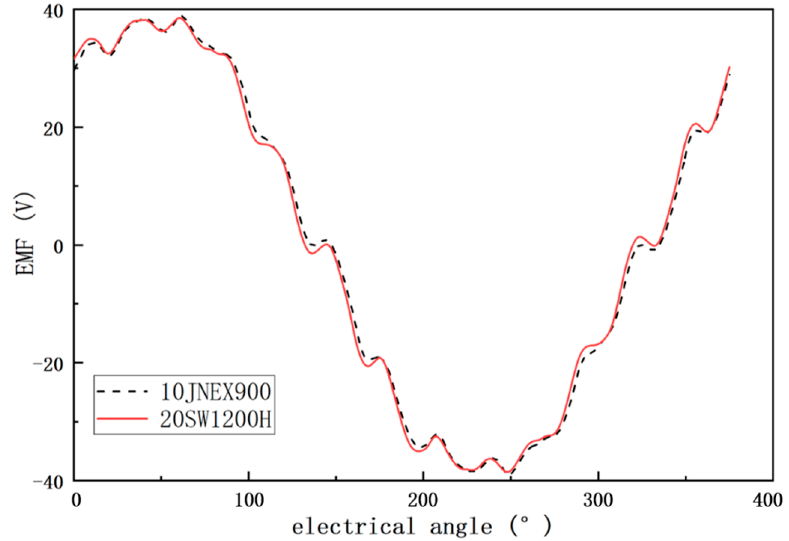
Figure 11. Comparison of no-load back EMF of 10JNEX900 and 20SW1200H motors.